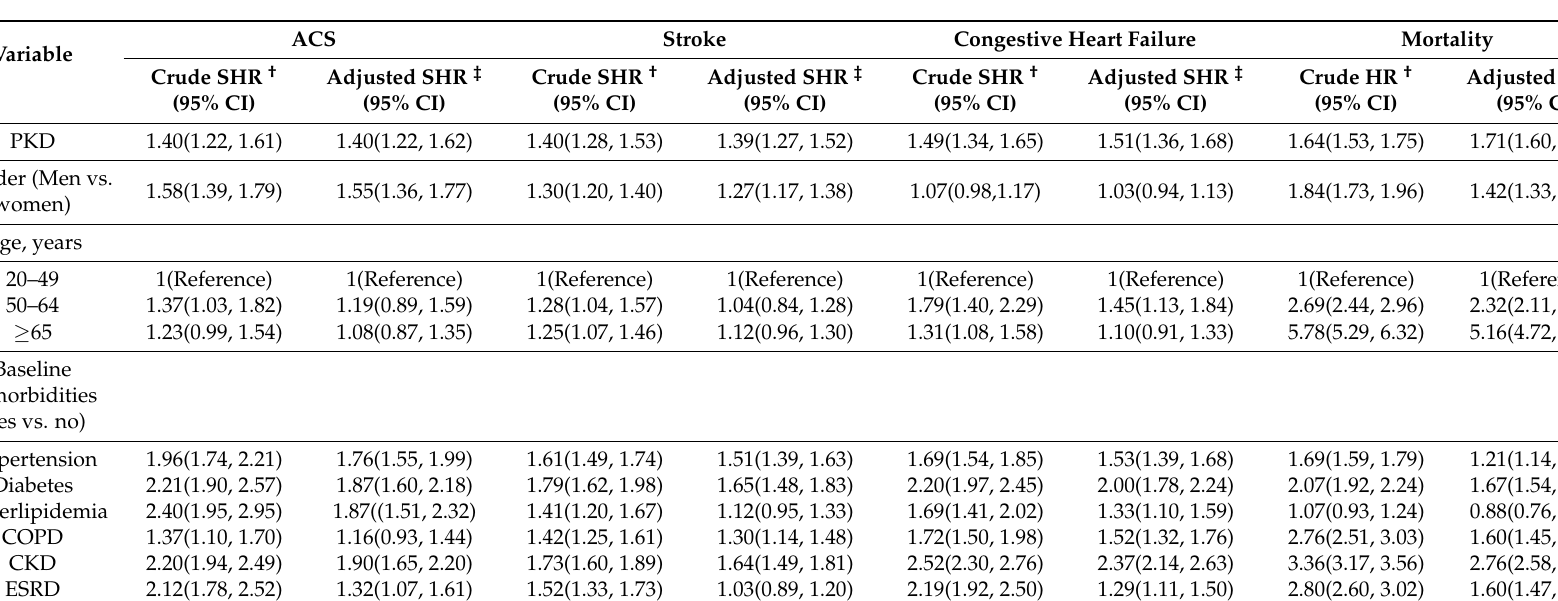
Table 4. Hazard ratios of outcome in association with gender, age and comorbidities in univariable and multivariable competing risk